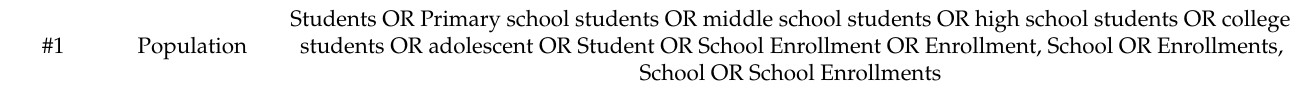
Table 1. Syntax sets used for searching